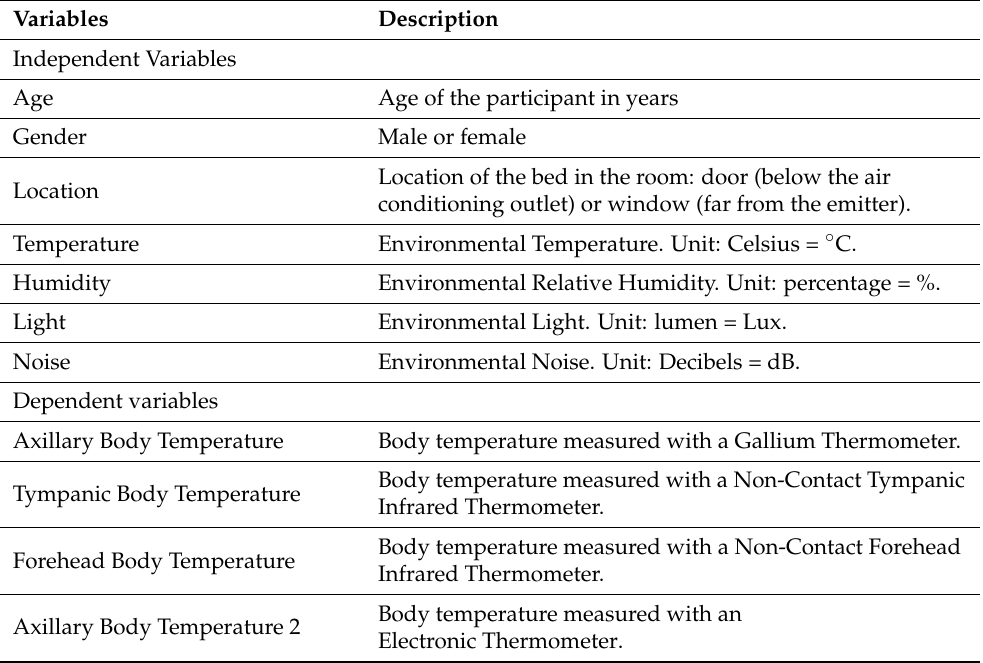
Table 1. Independent and dependent